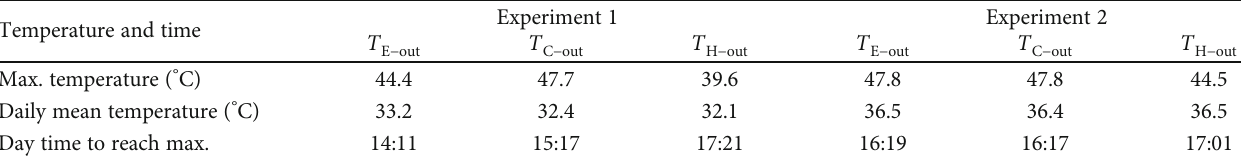
Table 9: Summarized results of the external side temperatures of the south wall and the Trombe wall. Temperature and time Daily mean temperature ( ° C) Day time to reach